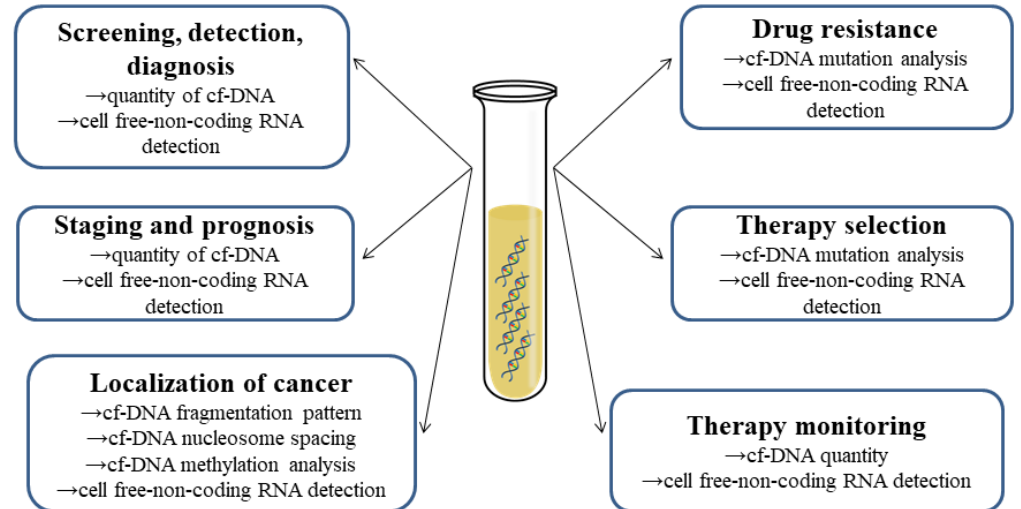
Figure 1. Utilization of cell-free Nucleic Acids in cancer diagnostics and treatment.